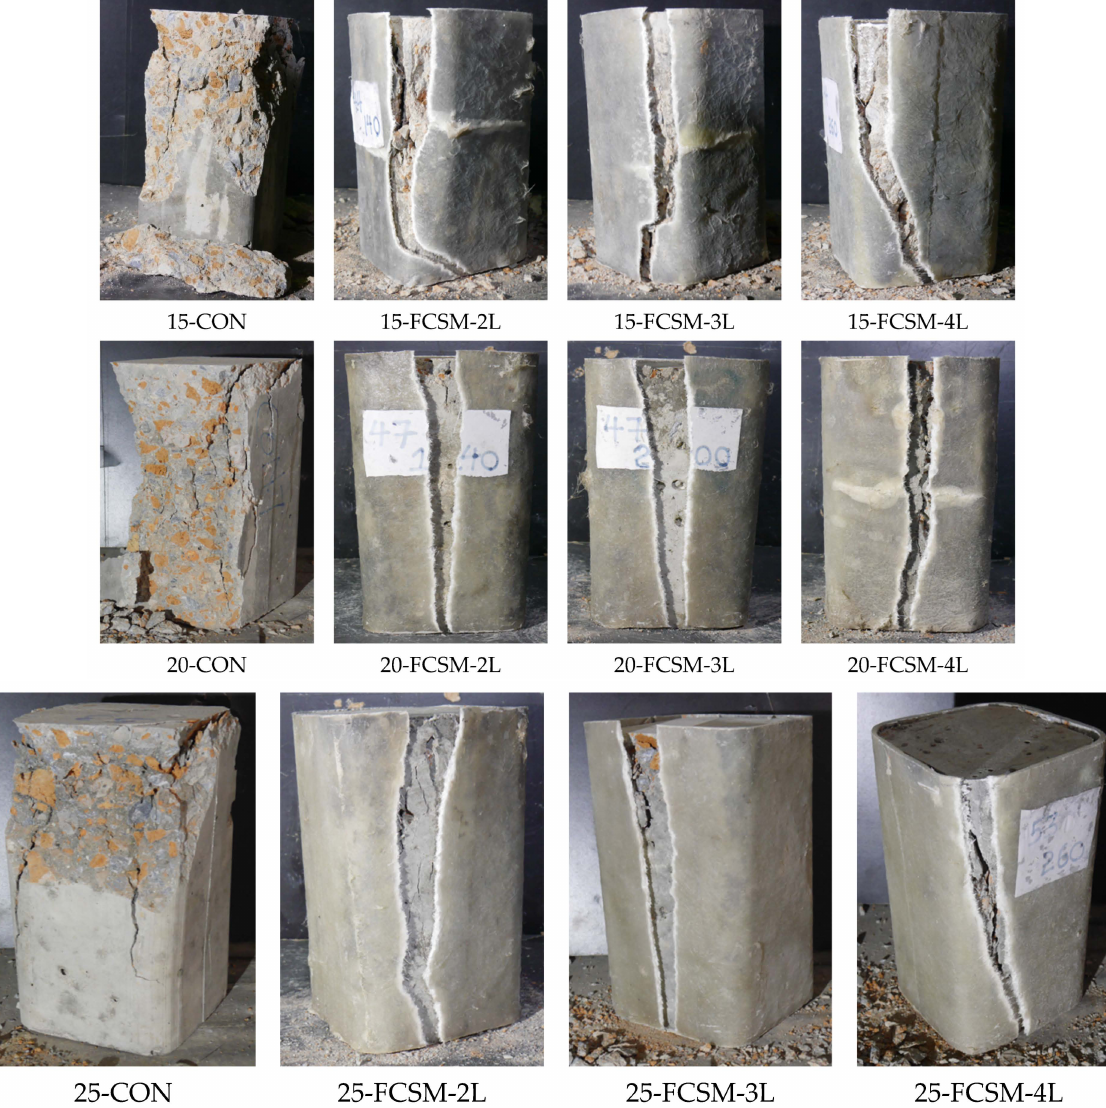
Figure 6. Failure